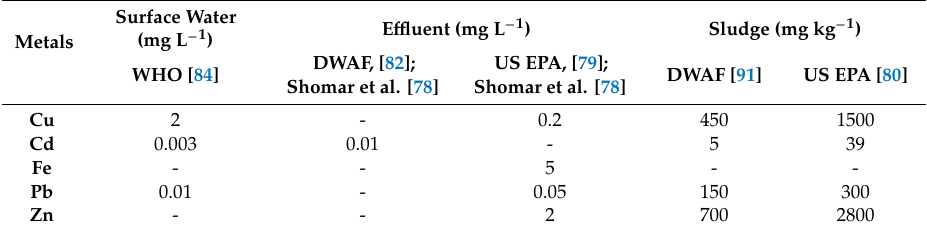
Table 2. Guidelines for metallic element in surface water, e ffl uent and sewage sludge.